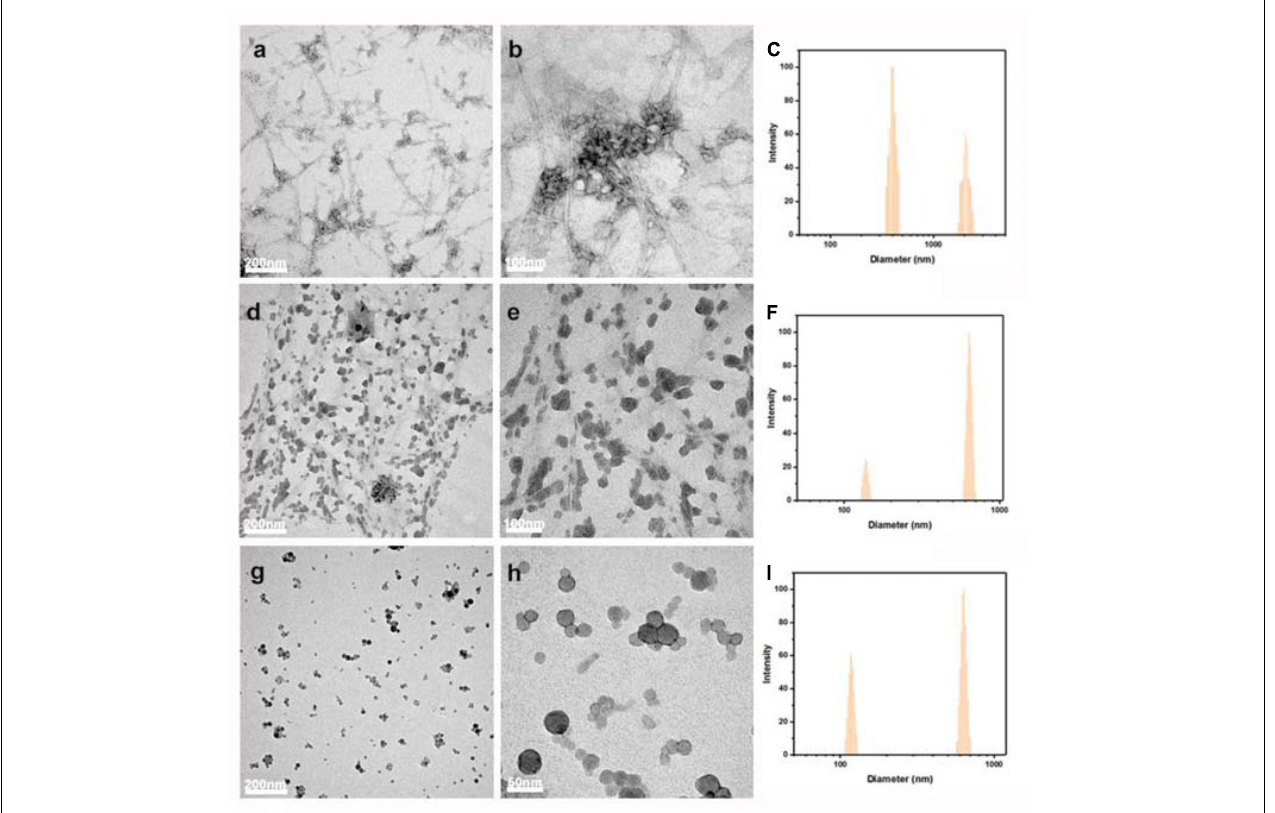
FIGURE 3 | TEM images and the measured size distribution by DLS of LCNFs-48 h (a–c) ; LCNFs-72 h (d–f) ; and LNPs-108 h (g–i) .